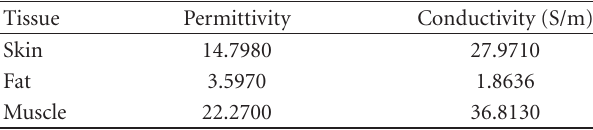
Table 1: Dielectric properties of human tissues at 31.5